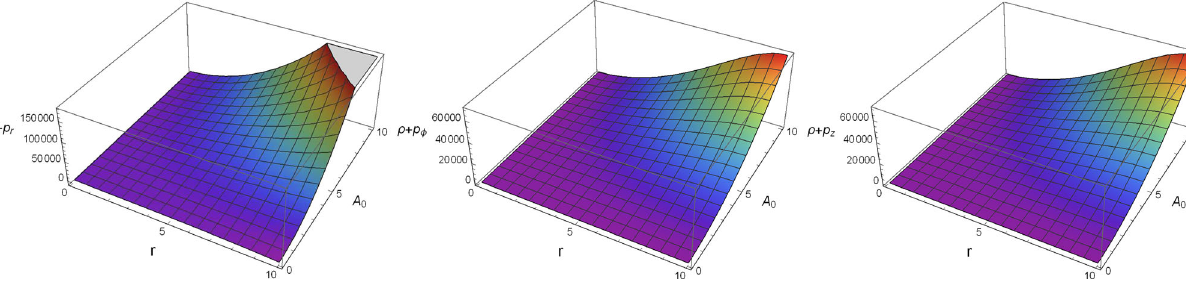
Fig. 14 This panel shows the variation of (ρ + p r ) (MeV/fm 3 ) and (ρ + p φ ) (MeV/fm 3 ) and (ρ + p z ) (MeV/fm 3 ) w.r.t r (km) and A 0 parameter with m = n = 1. CASE